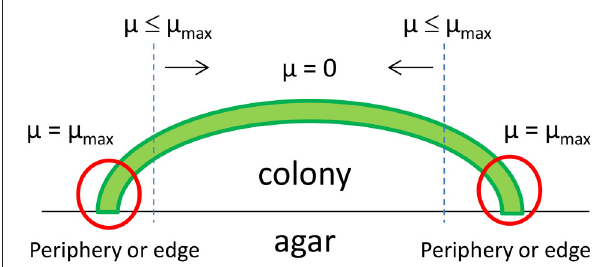
FIGURE 5 | Simplified model illustrating the spatial variations in the specific growth rate ( µ ) within a growing bacterial colony of a facultative anaerobe, such as Salmonella Typhimurium. Adapted from McKay et al.